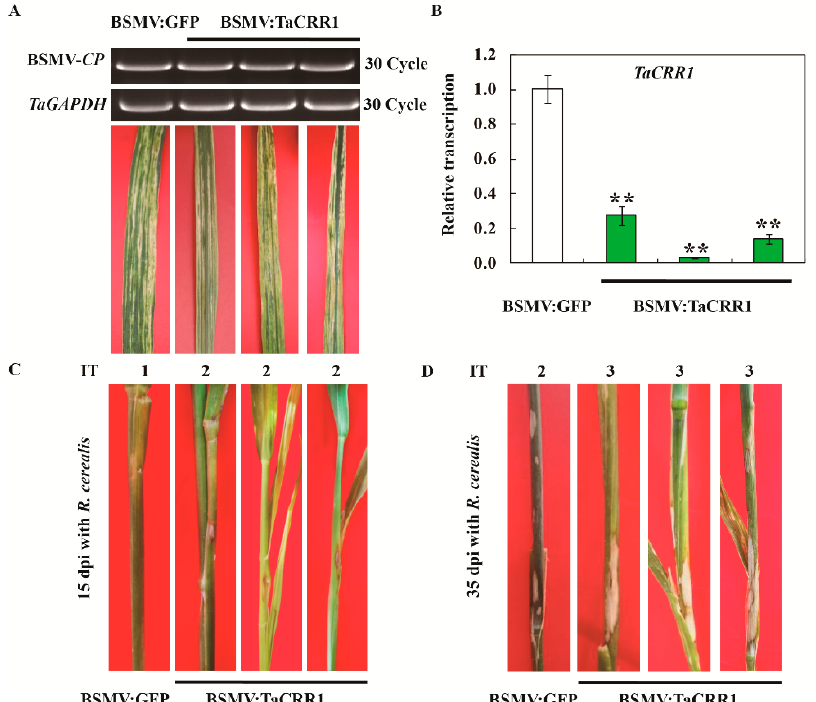
Figure 7. Silencing of TaCRR1 by barley stripe mosaic virus (BSMV)-induced gene silencing impairs resistance of the resistant wheat cv. CI12633 to Rhizoctonia cerealis . ( A ) RT-PCR analysis of the transcription of BSMV coat protein ( CP ) in the wheat plants infected by BSMV: GFP or BSMV: TaCRR1 for 10 d. Mild chlorotic mosaic symptoms were observed on leaves of wheat CI12633 at 10 dpi with BSMV: GFP or BSMV: TaCRR1. ( B ) qRT-PCR analysis of the TaCRR1 gene in the wheat plants infected by BSMV: GFP or BSMV: TaCRR1 for 10 days. The relative transcript level of TaCRR1 in BSMV: TaCRR1-infected wheat CI12633 plants is relative to that in BSMV: GFP-infected CI12633 (control) plants (set to 1). TaGAPDH was used as an internal control. Three replicates were averaged and statistically treated ( t -test: ** p < 0.01). Bars indicate the standard error of the mean. ( C ) Sharp eyespot symptoms on sheaths and stems of the control and TaCRR1 -silenced CI12633 plants at 15 dpi with R. cerealis . ( D ) Sharp eyespot symptoms on stems of the control and TaCRR1 -silenced CI12633 plants at 35 dpi with R. cerealis .